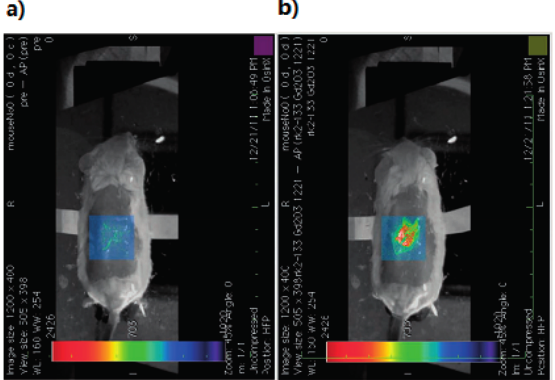
Figure 5. PAT-MRI images of tumor ( a ) before and ( b ) after injection of Gd 2 O 3 -DEG-gelatin. (Reprinted from reference [46]. Copyright with permission from © 2012 WILEY-VCH Verlag GmbH & Co. KGaA,